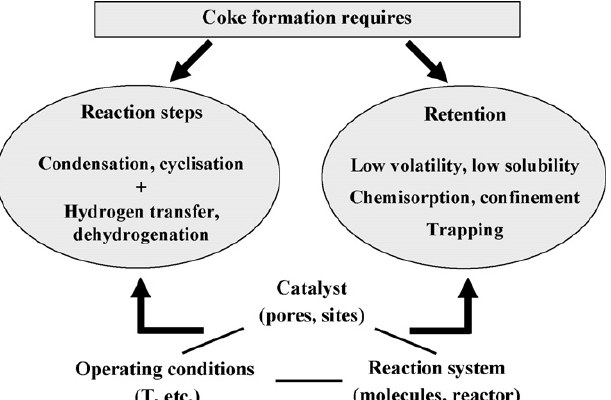
Figure 10. Necessary conditions for coke formation over catalysts and major influencing parameters. Guisnet et al. [75].